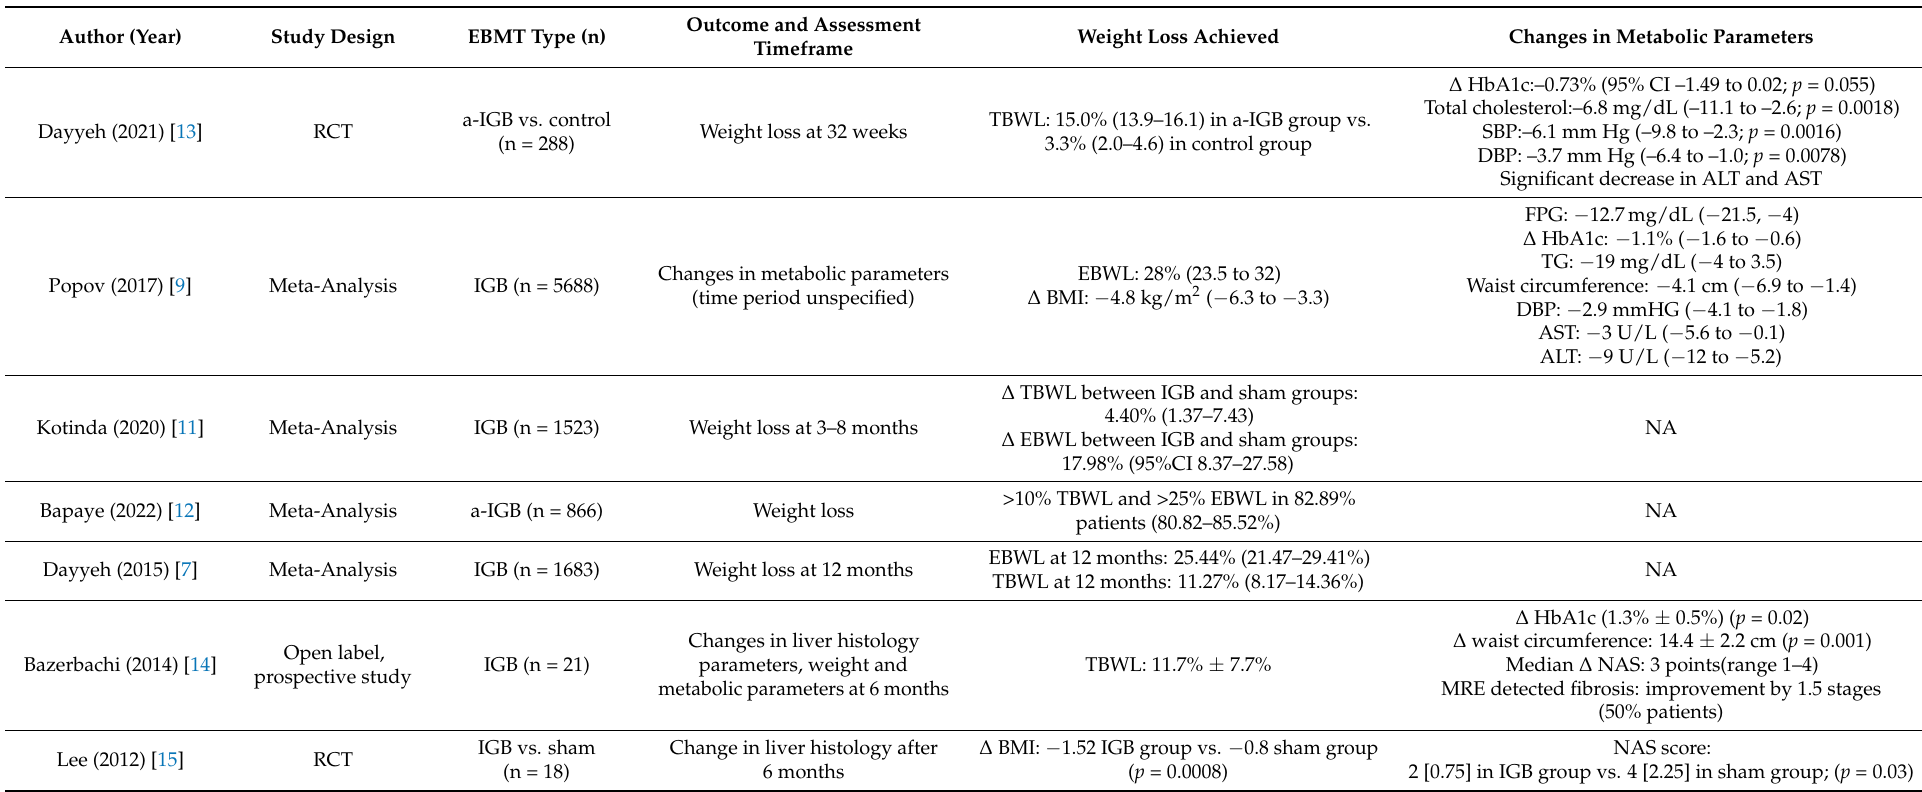
Table 1. Weight loss with Intra-gastric